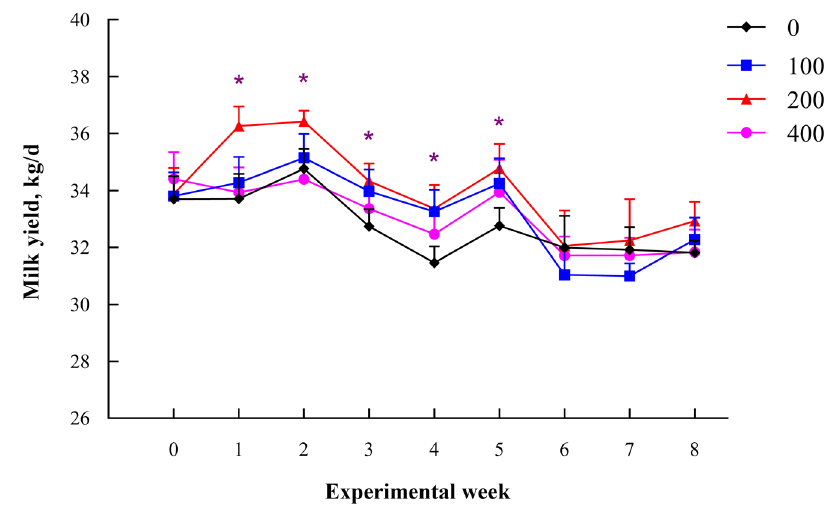
Figure 1. Changes in milk yield of mid-lactating cows fed on a basal diet with 0, 100, 200, 400 g/d of dandelion supplemented. Bars indicate standard error of the mean; Asterisk (*) indicates significant differences (p<0.05) between the control (0) and dandelion (200 g/d)